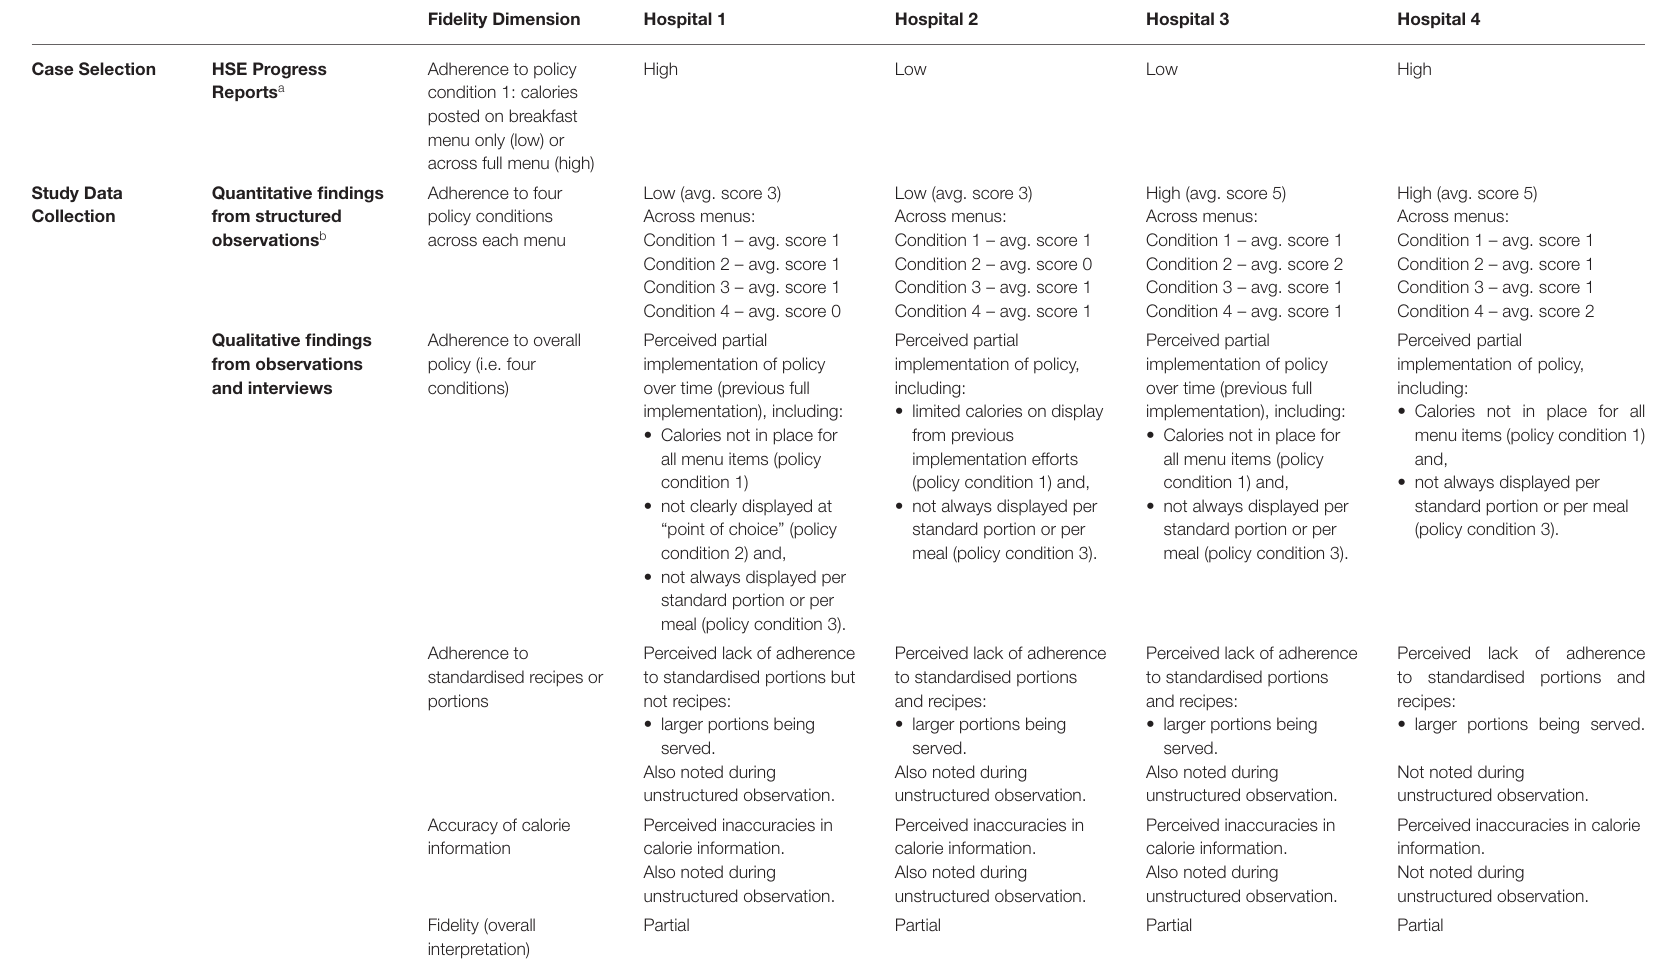
TABLE 3 | Summary of indicators of fidelity according to data